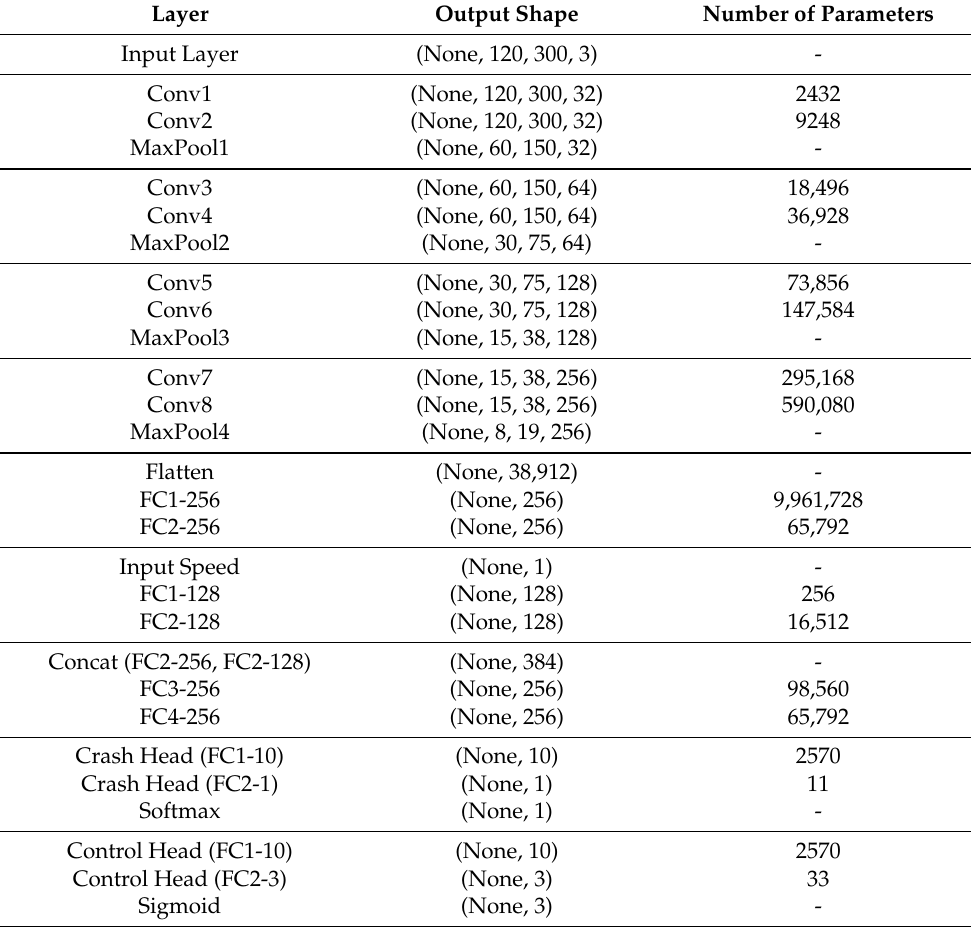
Table 1. Multitask network